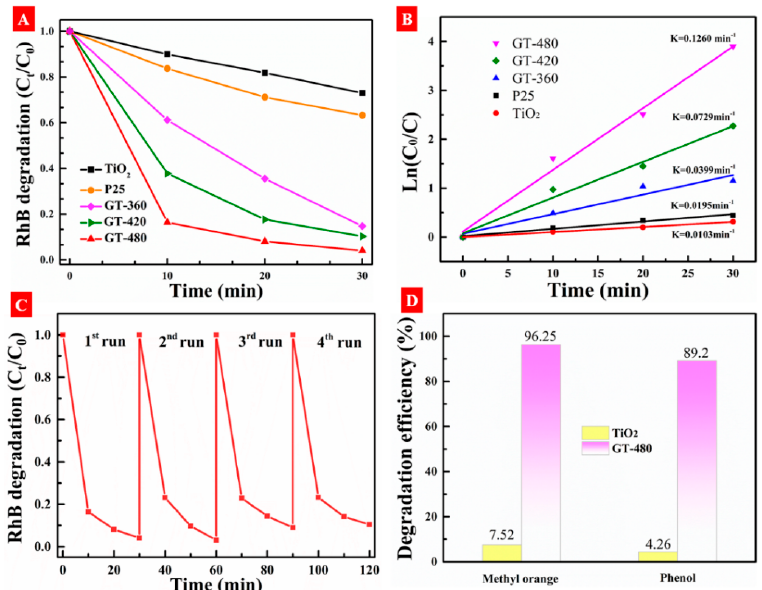
Figure 9. ( A ) Photocatalytic degradation curves of RhB(Rhodamine B) over di ff erent photocatalysts under visible-light irradiation. ( B ) The pseudo-first-order reaction rate constant for all samples. ( C ) Recycling test results using GT-480 as the photocatalyst. ( D ) Photodegradation rates of methyl orange and phenol with TiO 2 and GT-480 under visible-light